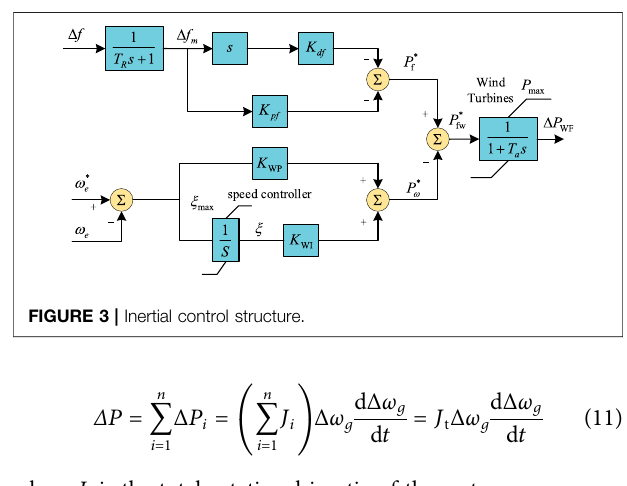
FIGURE 3 | Inertial control structure.